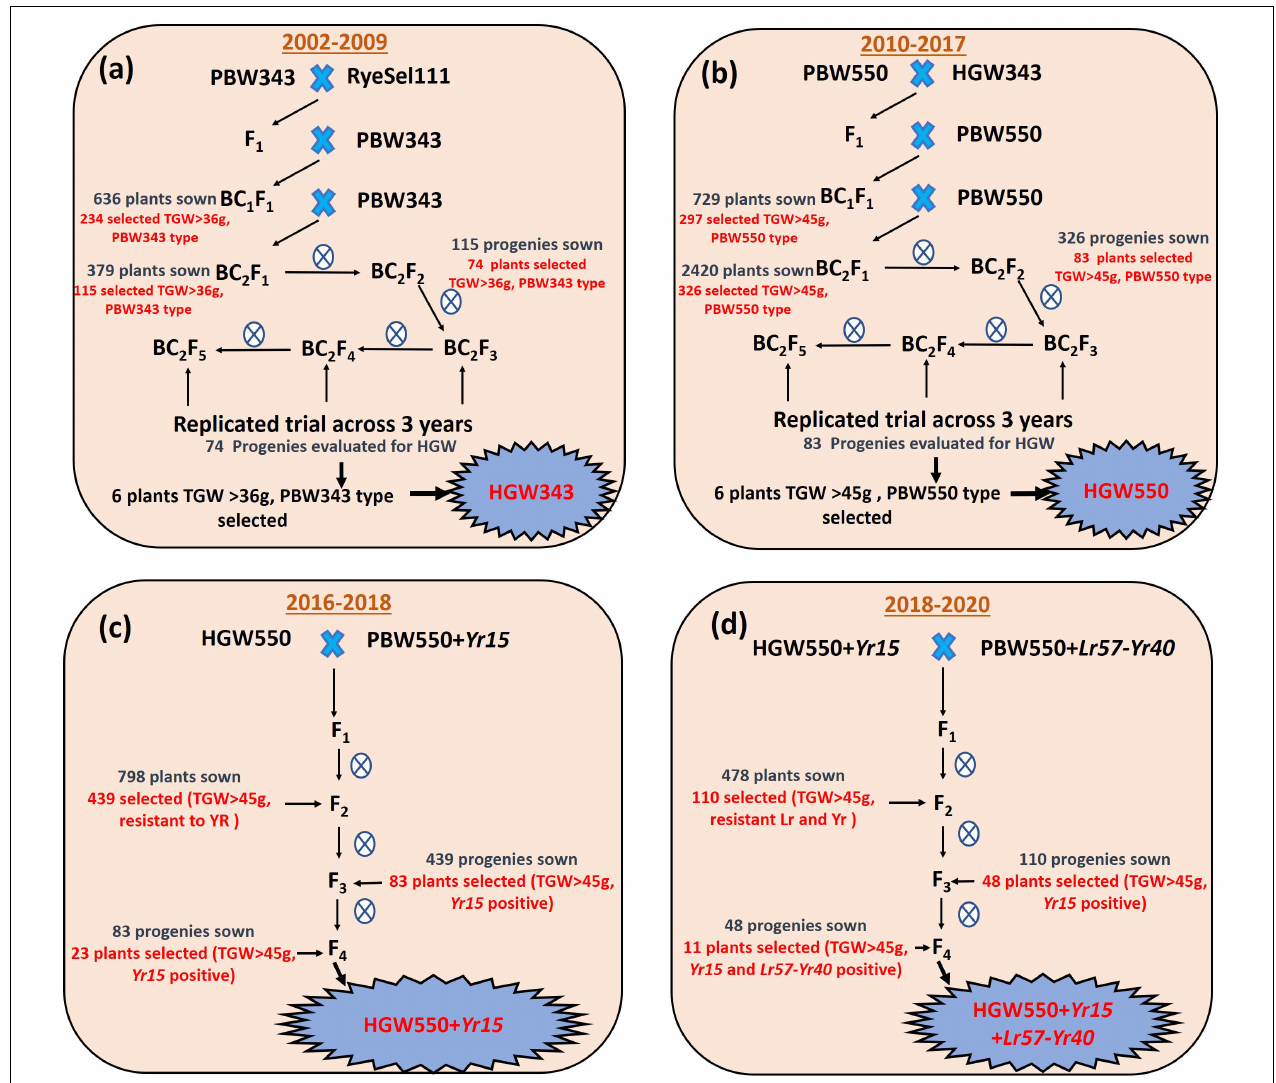
FIGURE 1 | Schematic view of the transfer of high thousand grain weight to (a) wheat variety PBW343 to obtain HGW343. (b) Wheat variety PBW550 to obtain HGW550. (c) Combining HGW550 with stripe rust resistance gene Yr15 . (d) Combining HGW550 + Yr15 with linked leaf rust and stripe rust resistance gene